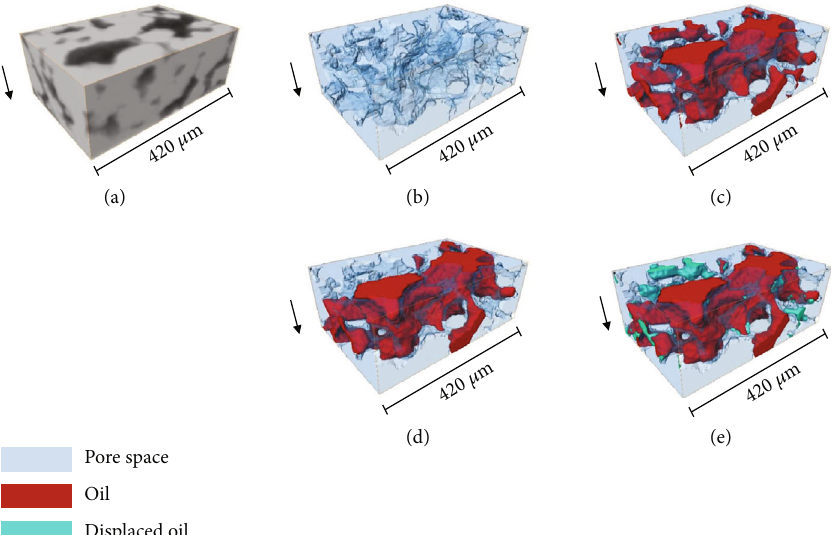
Figure 3: Oil and water distribution in the local core: (a) dry situation, (b) pore structure, (c) saturated oil situation, (d) residual oil situation, and (e) changing of oil distribution.